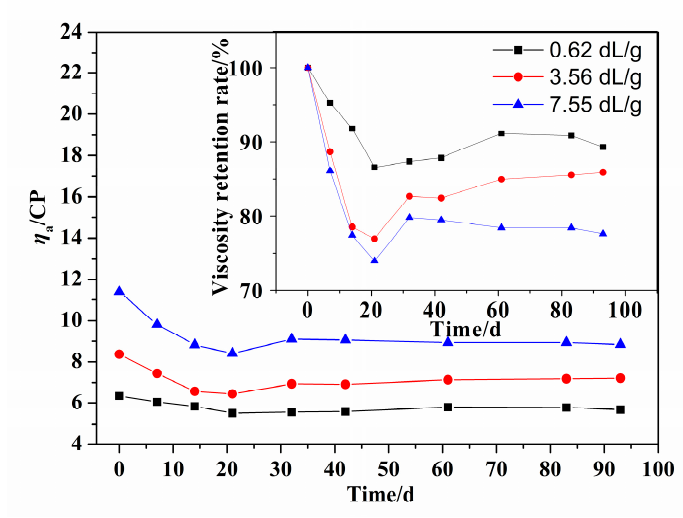
Figure 9. Effect of [ η ] on η a of PMAPTAC solution.